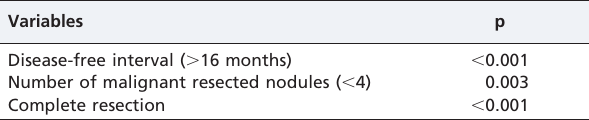
Table 4 - Multivariate analyses of the overall